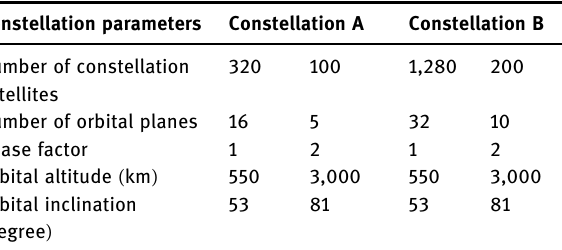
Table 2: Main parameters of the complex constellation Constellation parameters